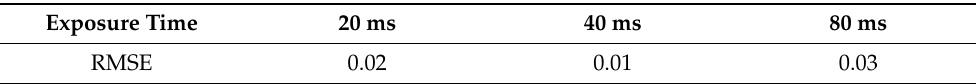
Figure 13. Comparison of displacement measurement error under different exposure times. Table 1. Root mean square error of displacement measurement (mm).